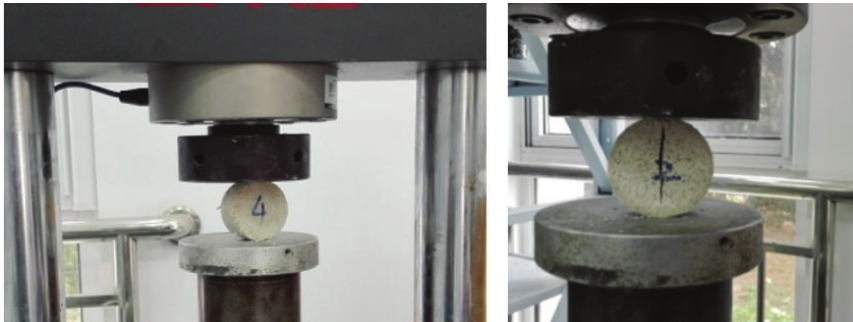
Figure 10: Flattened Brazilian disk test or tensile splitting test.